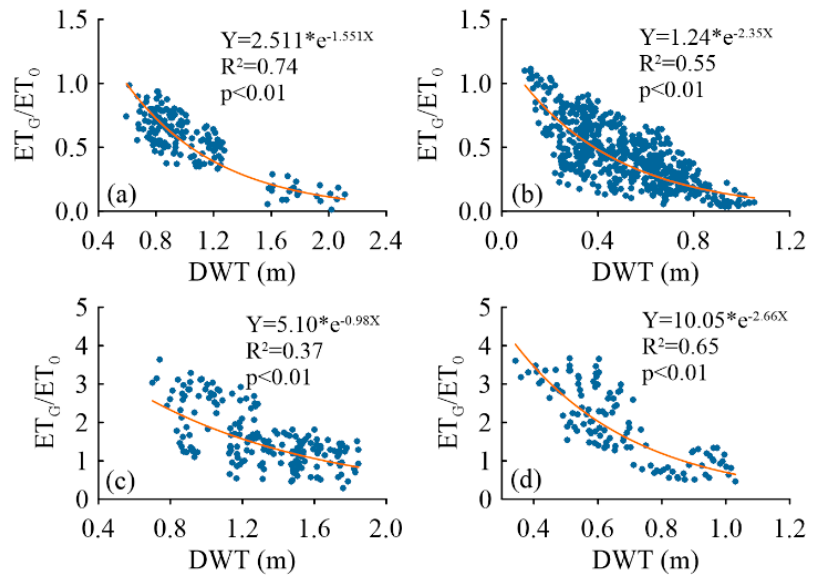
Figure 9. The relationship between the ratio of ET G to ET 0 (ET G /ET 0 ) and DWT for ( a ) the Achnatherum splendens site, ( b ) the Carex stenophylla site, ( c ) the Salix psammophila site, and ( d ) the Populus alba site.